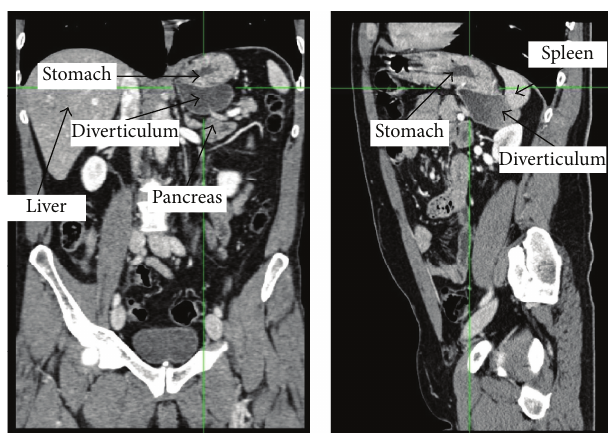
Figure 1: Arterial phase CT scan (frontal and sagittal planes) showing a large diverticulum of the size of 52 × 68 × 72 millimeters protruding from the gastric fundus, with fluid content. The retroperitoneal location of the pouch is well visible in the sagittal scan, as well as its tight adhesions with the inferomedial surface of the spleen, the ipsilateral adrenal gland, and the upper posterior surface of the body and tail of the pancreas.